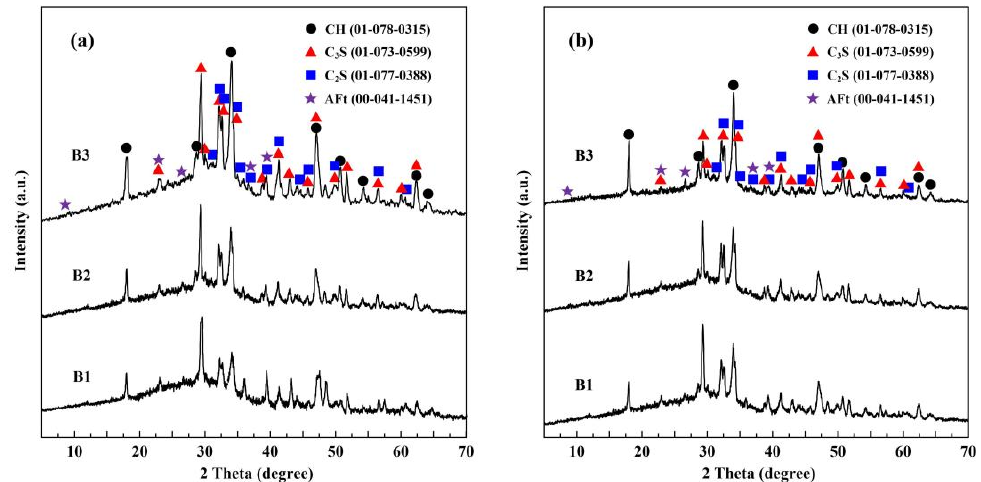
Figure 5. The XRD patterns of cement matrix and interface transition zone of specimens B1–B3 after 28 days curing time. ( a ) cement matrix, ( b ) interface transition zone.